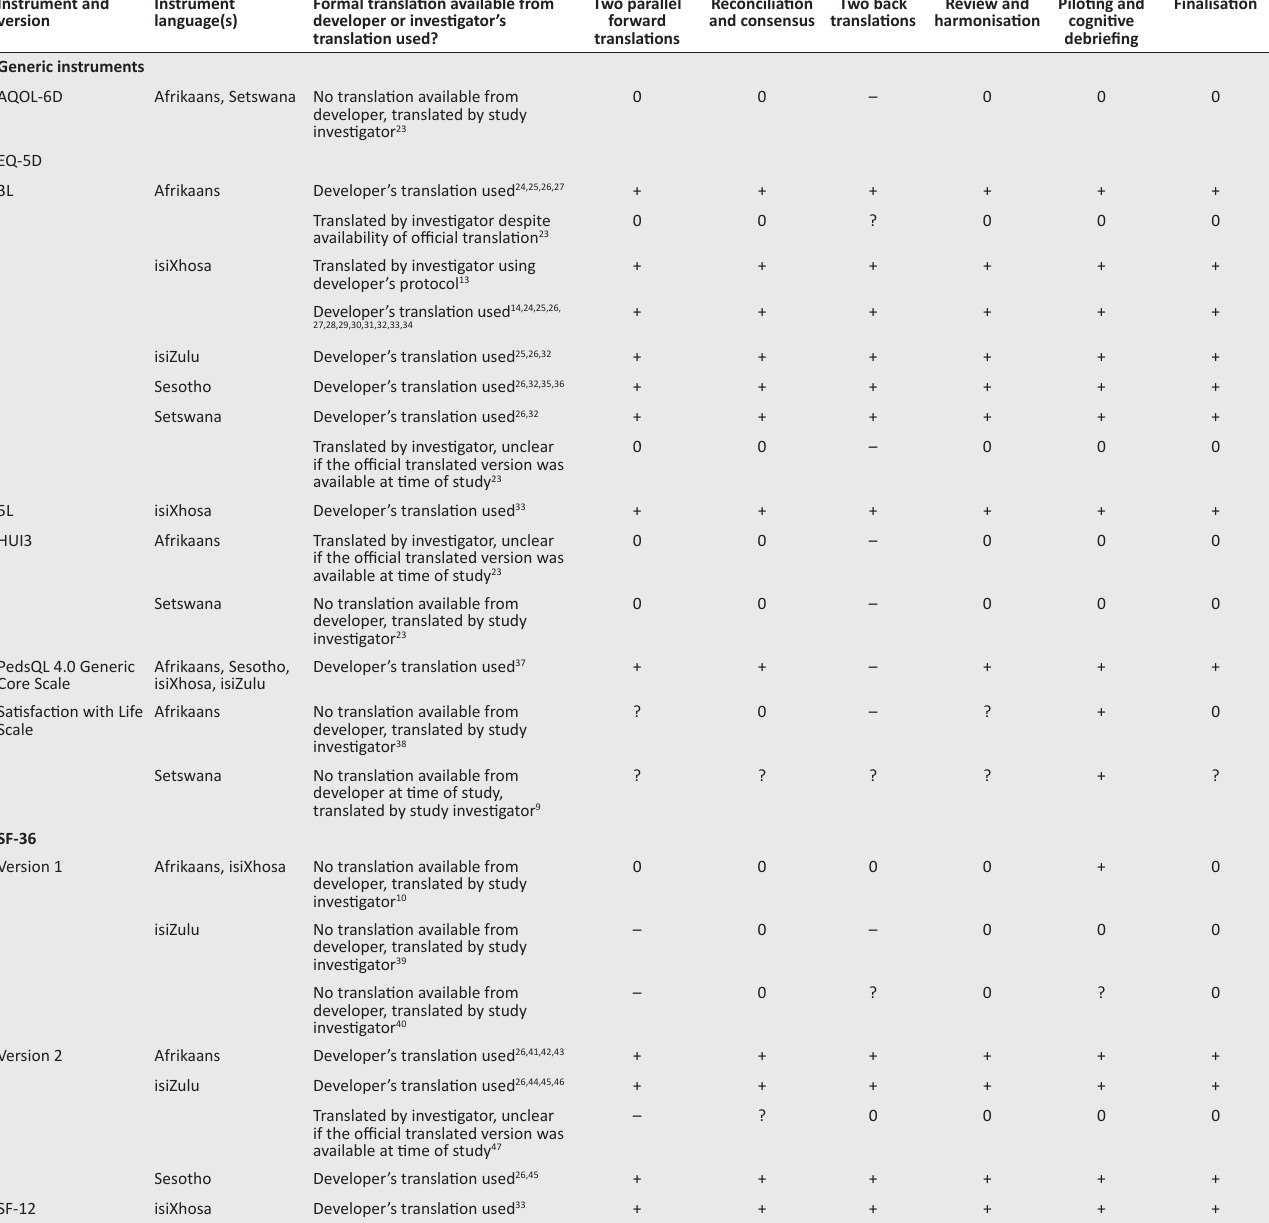
TABLE 3: Stages in instrument translation methodology. Instrument and version